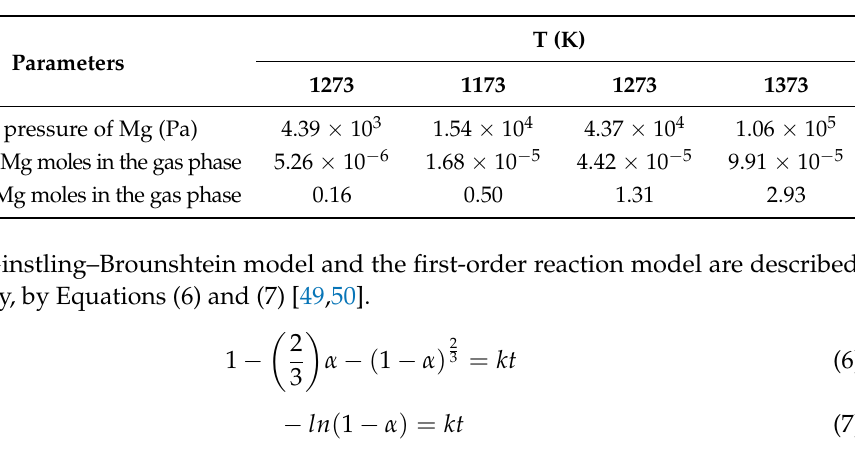
Table 2. Vapor pressure and number of Mg moles in the gas phase; (vapor pressure is calculated by FactSage 8.1).